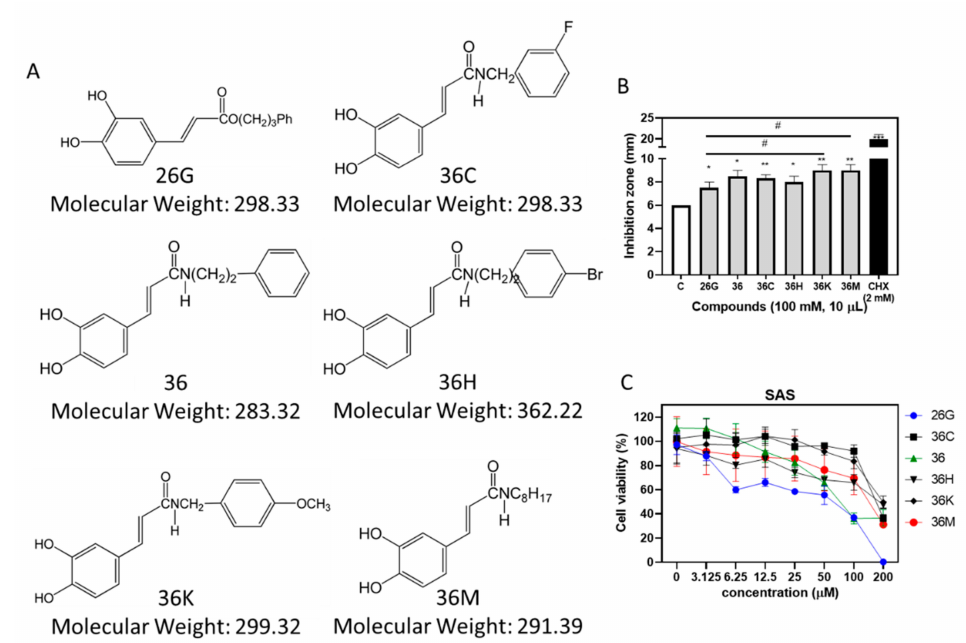
Figure 1. Antibacterial and anticancer activities of the caffeic acid phenethyl ester (CAPE) and caffeamide derivatives. ( A ) The chemical structures and formula of the CAPE derivatives (26G) and caffeamide derivatives (36C, 36, 36H, 36K, and 36M). ( B ) The diameter of inhibition zones of CAPE and caffeamide derivatives on S. mutans culture agar plates. ( C ) The cytotoxicity of caffeamide derivatives on SAS cells. Column C, dimethyl sulfoxide (DMSO); Tukey’s multiple comparisons test, compared to C, * p < 0.05, ** p < 0.01, and *** p < 0.001; compared to 26G, # p < 0.05.